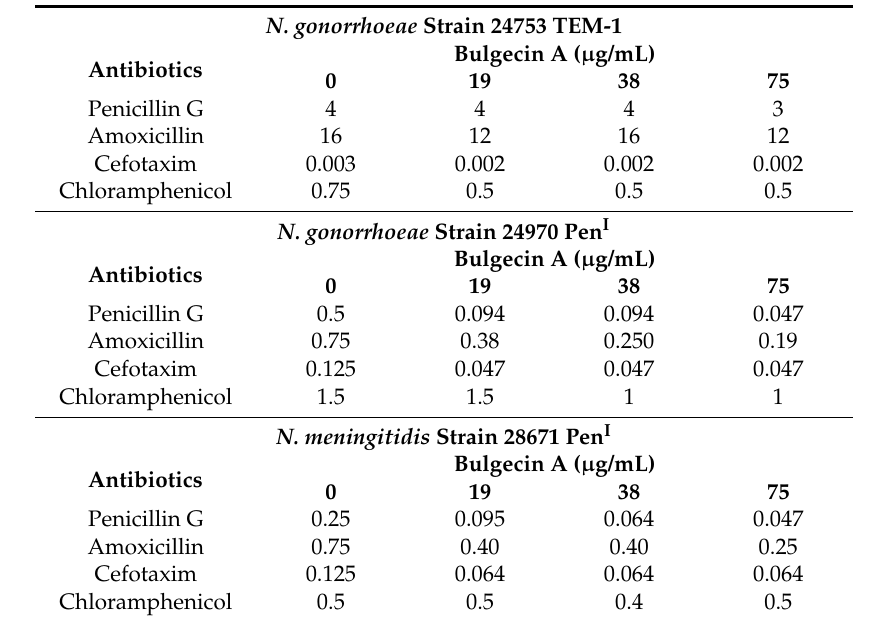
Table 2. The effect of β -lactams combined with bulgecin A on Neisseria species with reduced susceptibitility to β -lactams. Minimal inhibitory concentrations (MICs) ( µ g/mL) of different antibiotics are shown, in the presence of 0–75 µ g/mL bulgecin